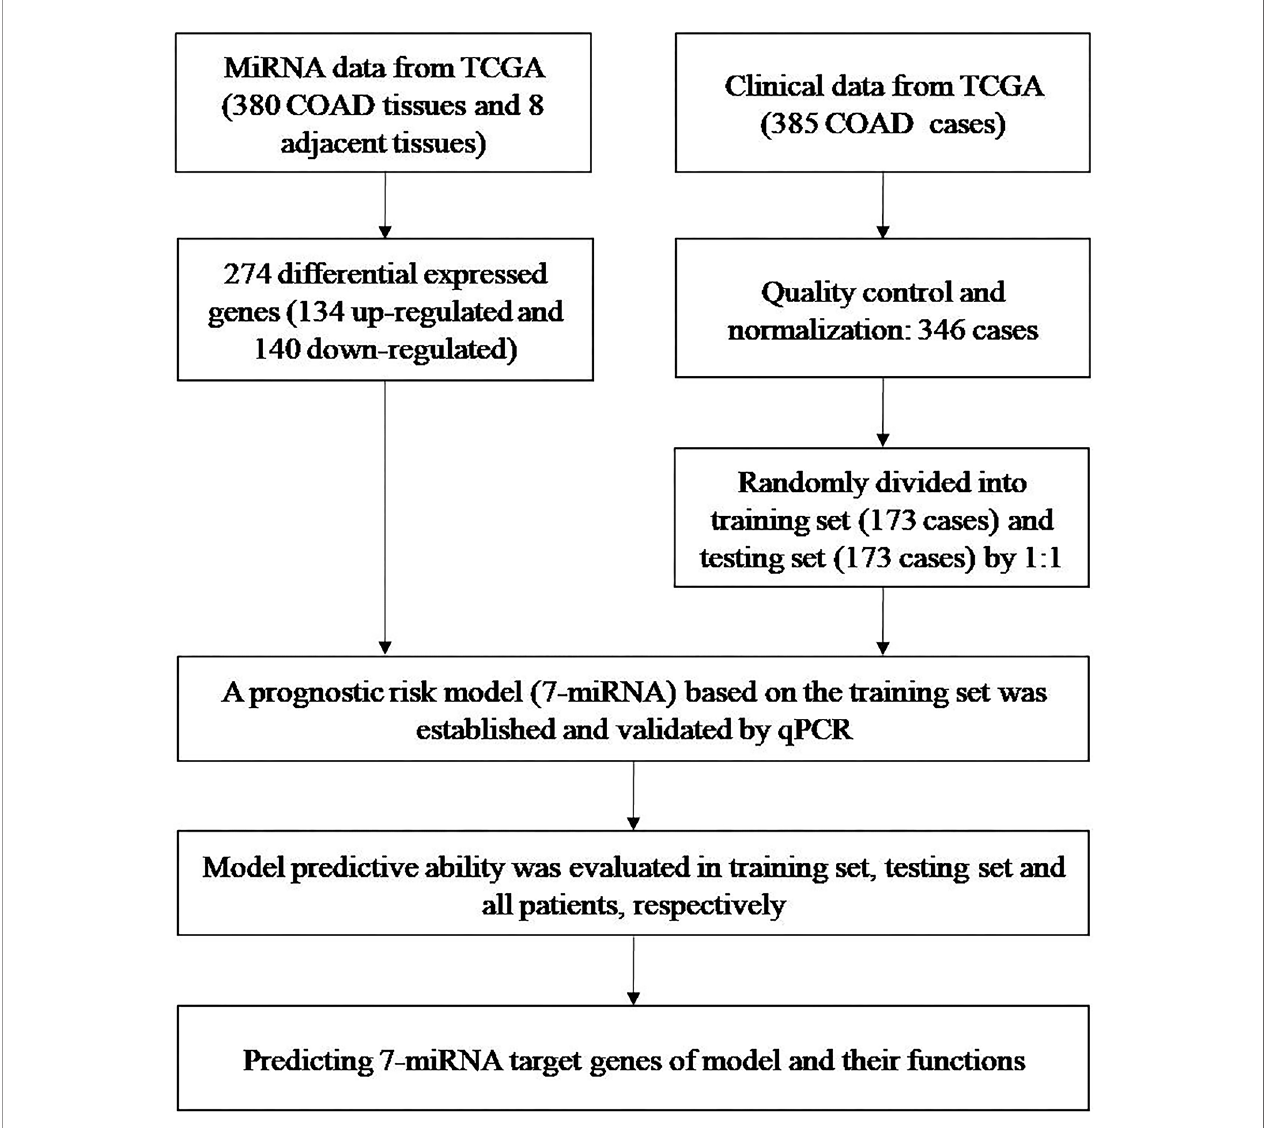
FIGURE 1 | Identi fi cation of miRNAs and clinical data from TCGA, development of a predictive model, and predicting the targets of the seven miRNAs in the